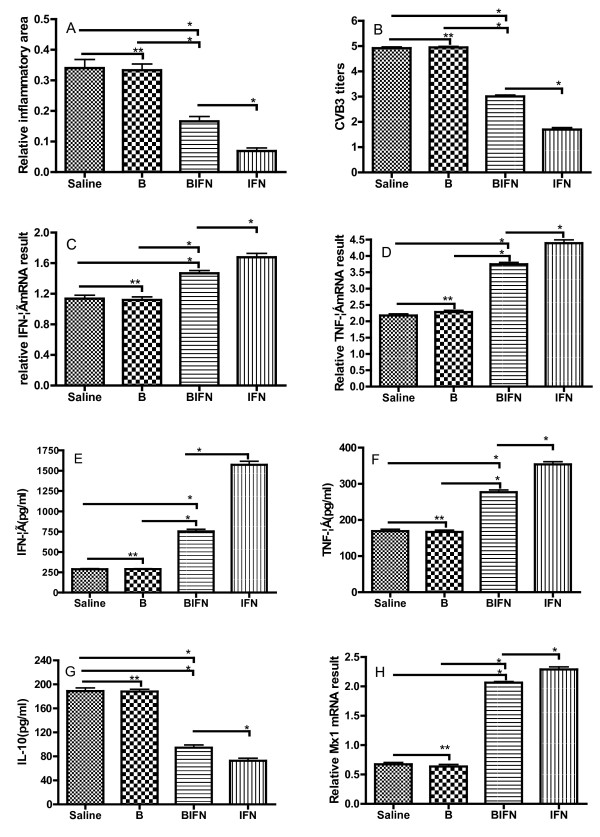
Pathological areas of the heart. The percentage of pathological areas in different groups was shown in (a). The coxsackievirus B3 (CVB3) titration detected by standard plaque formation assay was indicated in (b). The levels of interferon (IFN)-γ and tumor necrosis factor (TNF)-α mRNA were determined in (c) and (d) respectively. The concentration of, IFN-γ and TNF-α and were shown in (e, f and g) respectively. The detection of IFN-induced Mx1 mRNA was determined in (h). **versus B group, p >0.05; *versus BIFN group, p < 0.01.